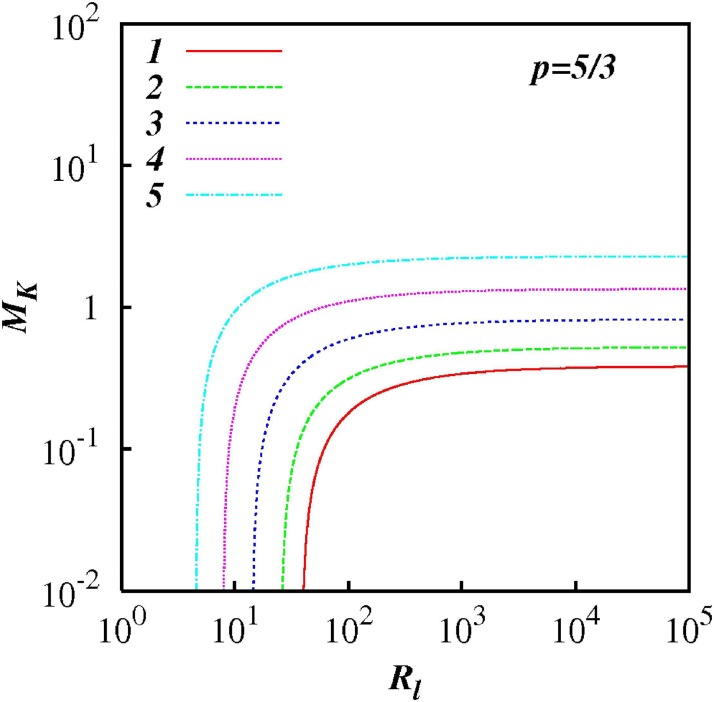
Similar to Fig 7, except for p = 5/3.